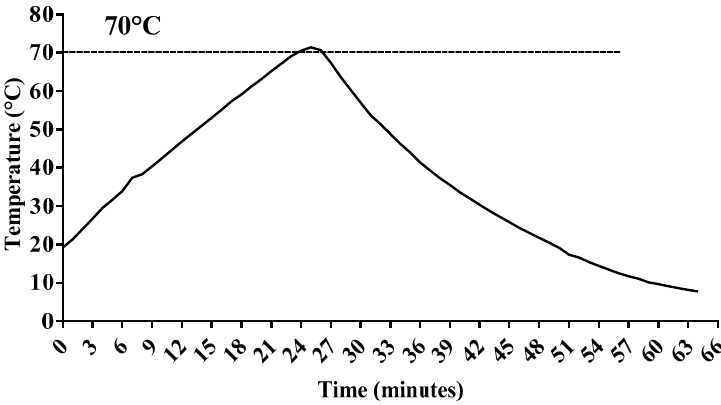
Figure 2. Time–temperature curve for the modified Holder pasteurization method.